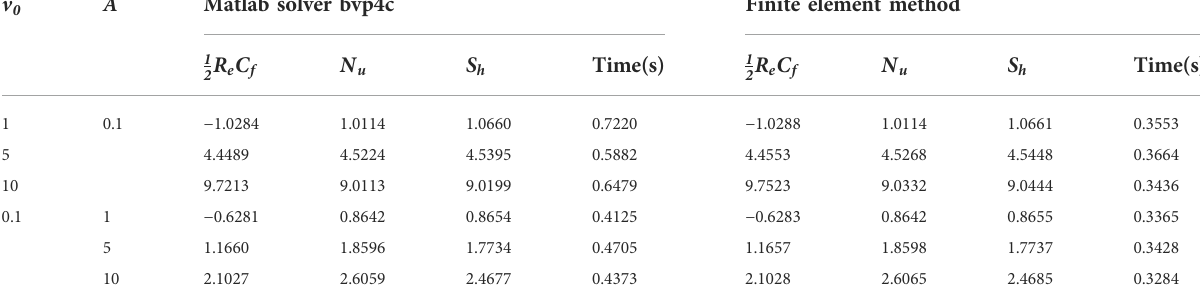
TABLE 1 Comparison of fi nite element method with Matlab solver bvp4c using Gr (cid:1) 1 , Gm (cid:1) 0 . 9 , β 1 (cid:1) 0 . 3 , β 2 (cid:1) 0 . 9 , R d (cid:1) 0 . 1 , P r (cid:1) 0 . 9 , S c (cid:1) 0 . 9 , γ (cid:1) 0 . 1 v 0 A Matlab solver